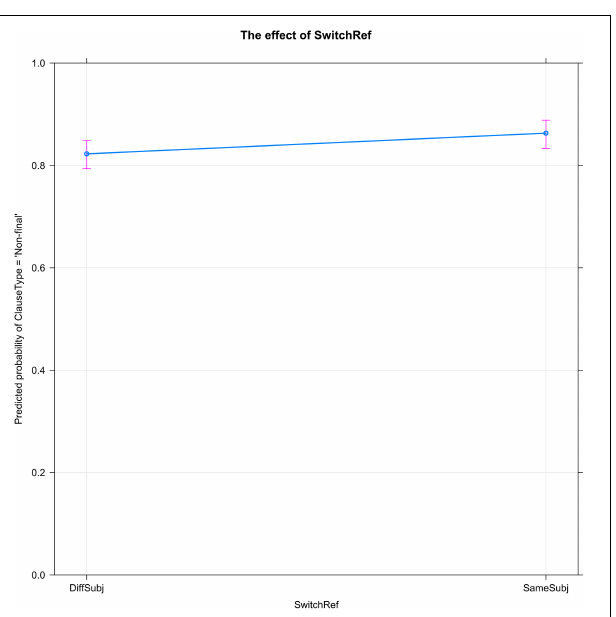
a decreased probability of clause